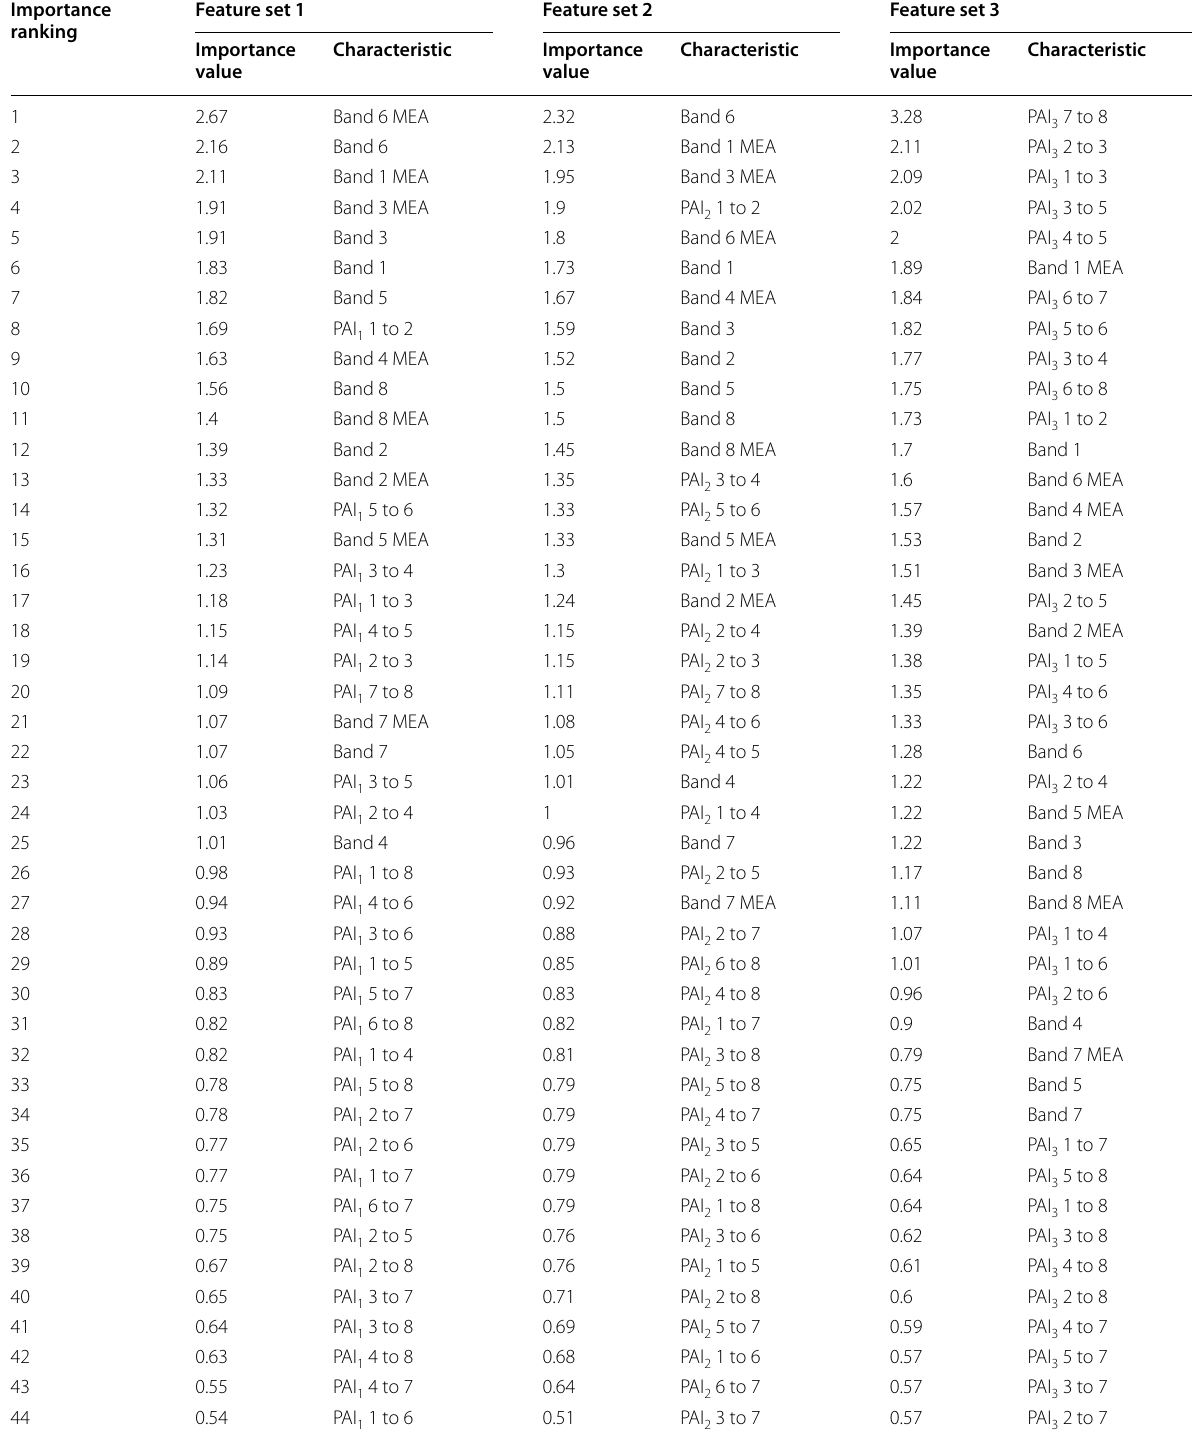
Table 8 Importance ranking of polygon area index features extracted by three algorithms in tree species classification based on feature sets and the results from